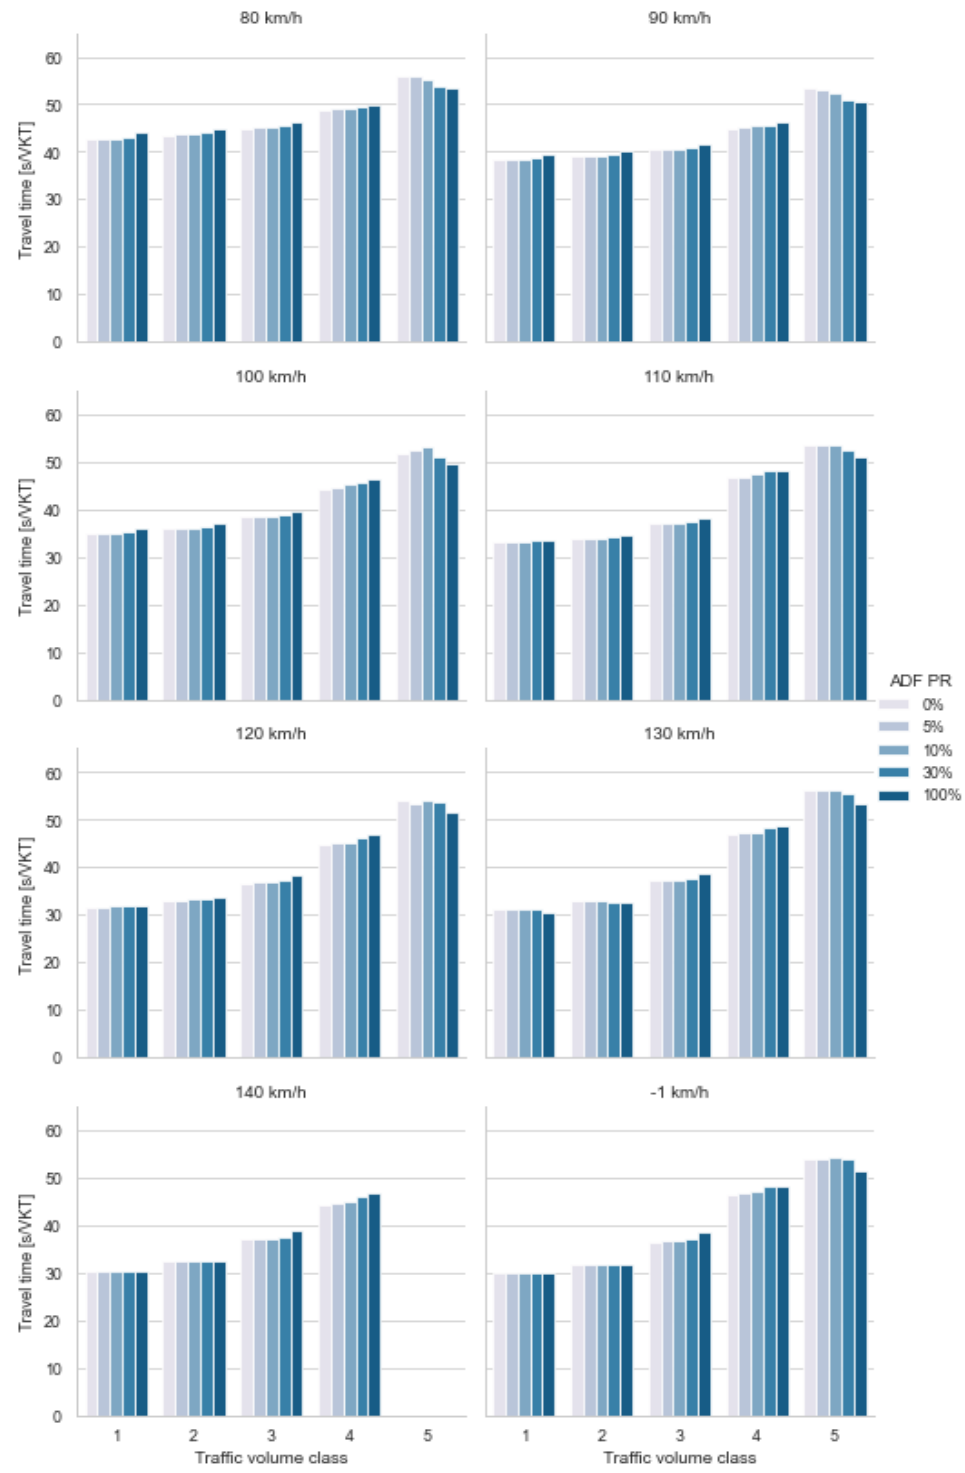
Figure 10. Average travel time in seconds per VKT for speed limits 80 to 140 km/h and unlimited (-1 km/h) per traffic volume class and AV penetration rate on EU27+3 motorways. Volume class 1: up to 750 veh/h/lane; 2: 751–1250 veh/h/lane; 3: 1251–1750 veh/h/lane; 4: 1751–2250 veh/h/lane; 5: over 2250